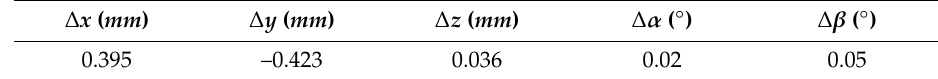
Table 7. Compensation amounts for the SM.